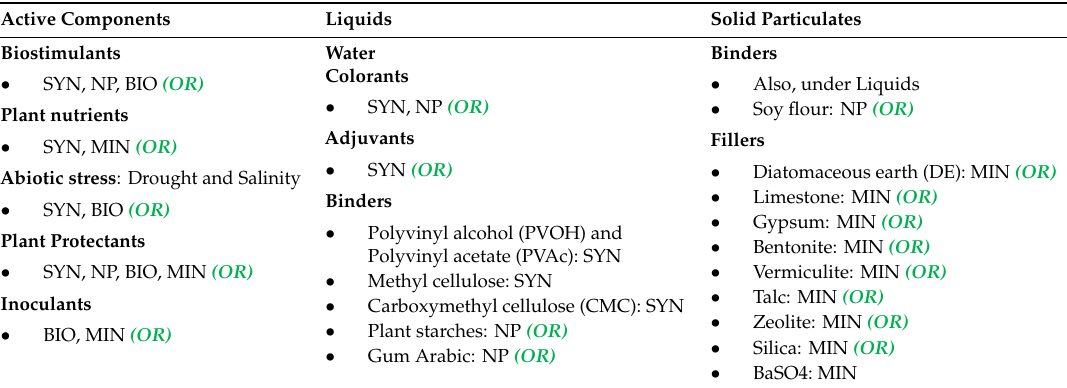
Table 1. Seed treatment and coating materials grouped as active components, liquids and solid particulates. Each group of material is further classified by function and composition. Abbreviations for material source / origin: Synthetic Chemicals—SYN, Natural products or derivatives—NP, Biologicals—BIO, Mineral—MIN, substances may be Organically approved—